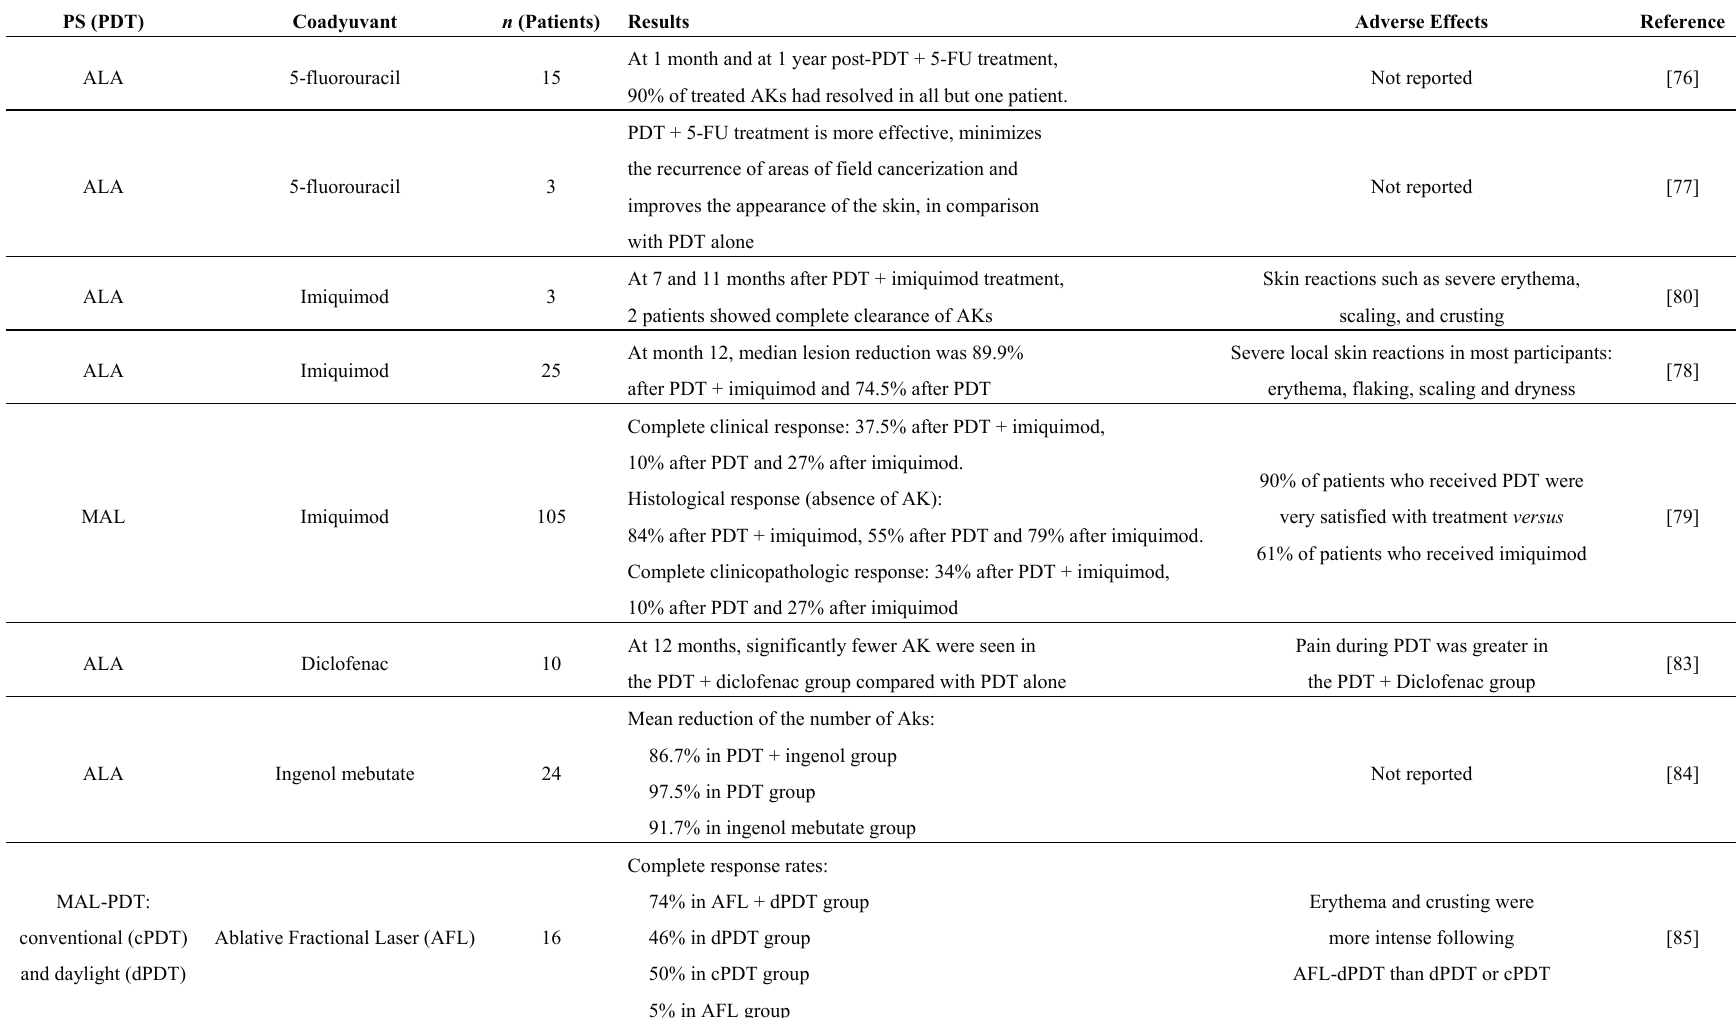
Table 1. Clinical studies of combined treatments with photodynamic therapy for actinic